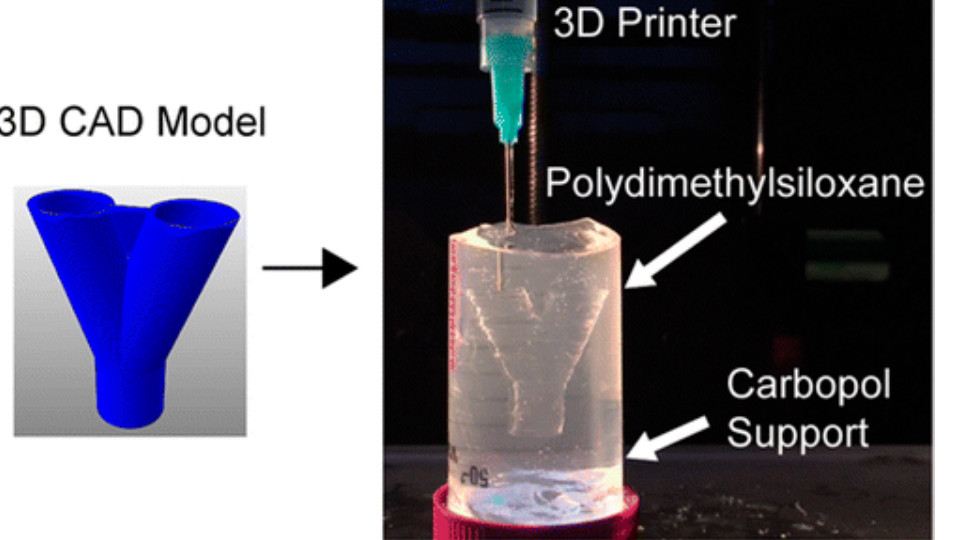
Figure 12. Three-dimensional printing of hydrophobic polydimethylsiloxane prepolymer resins within a hydrophilic Carbopol gel support via freeform reversible embedding